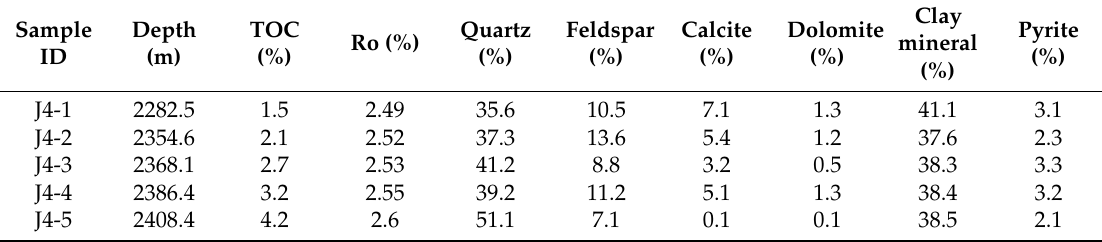
Geochemical characteristics and mineral compositions of Wufeng-Longmaxi (W-L) shale